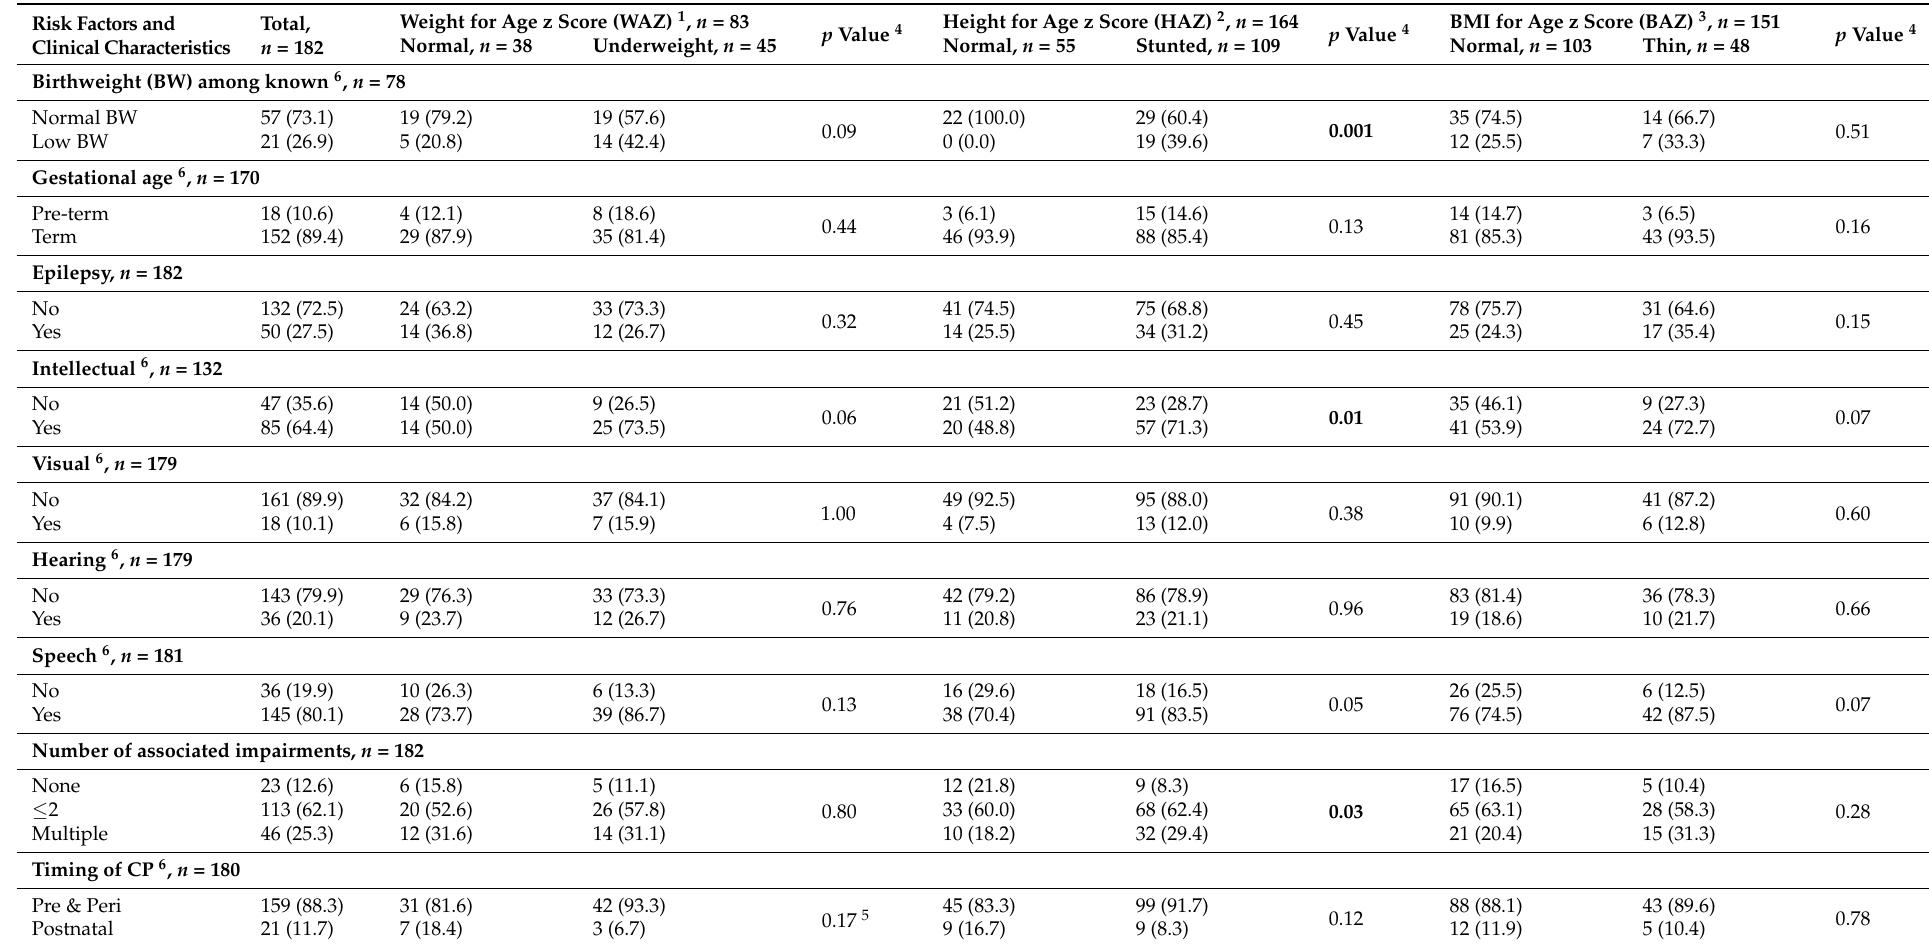
Table 3. Weight-for-age, height-for-age and BMI-for-age of children registered into the NCPR according to their clinical